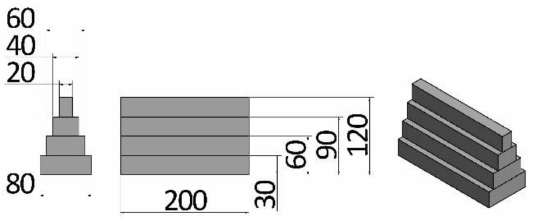
Figure 1. Casting